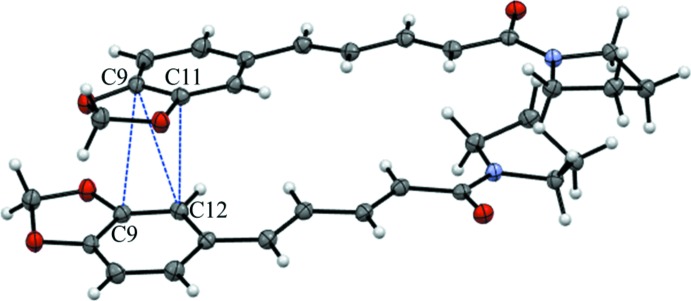
Fragment of the crystal of (II) showing close C⋯C contacts due to π–π stacking.